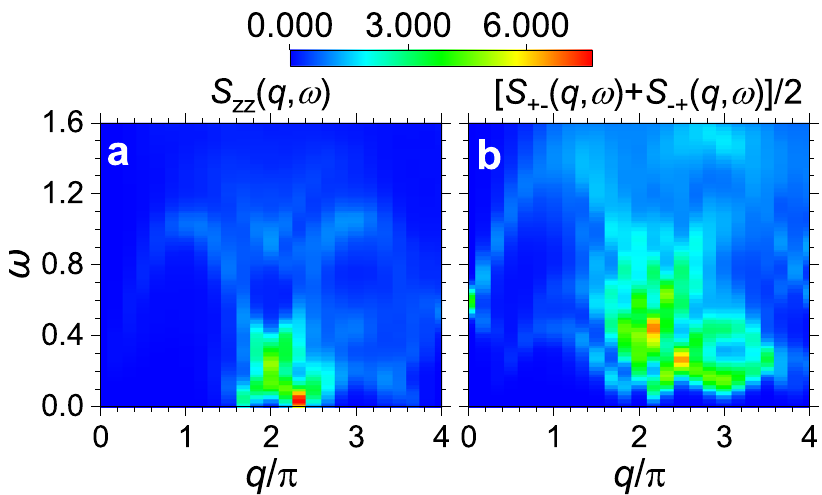
Fig. 6 Dynamical spin structure factor of phase II. a S zz ( q , ω ) and b [ S + − ( q , ω ) + S − + ( q , ω )]/2, obtained from the dynamic density matrix renormalization group for the kagome strip chain under the periodic boundary condition for L = 12 ( N = 5 × 12) at J 1 = 1.0 and J 2 = 0.7, where L is the number of the 5-site units, and J 1 and J 2 are the exchange interactions shown in Fig. 1. In addition, S zz ( q , ω ) corresponds to the S z component of the dynamical spin structure factor, and [ S + − ( q , ω ) + S − + ( q , ω )]/2 correspond to the S x and S y